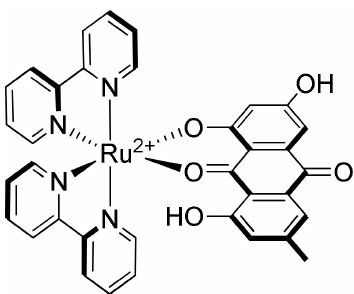
Figure 23. Structure of the [Ru(bpy) 2 ( emodin )] 2+ complex studied by Mei et al. [248].